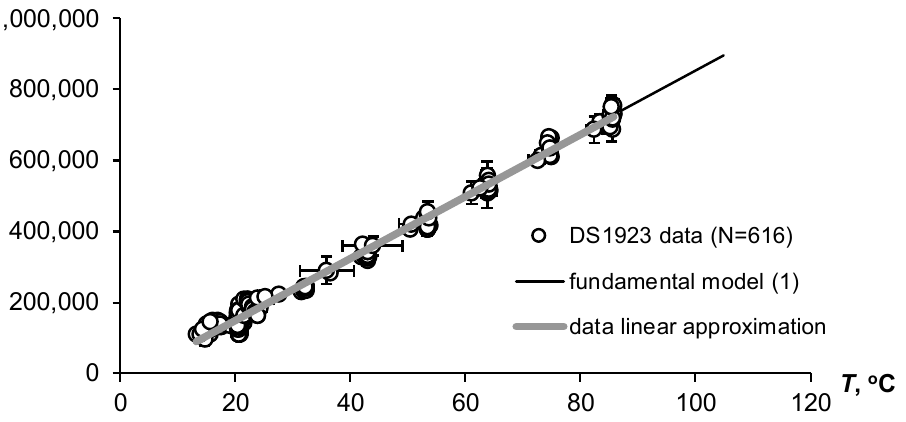
Figure 1. Experimental dependence of the water potential and temperature in the drying oven (estimated by data loggers DS 923) and its modeling.